Question: Based on the figure, does the quantity rise or fall?
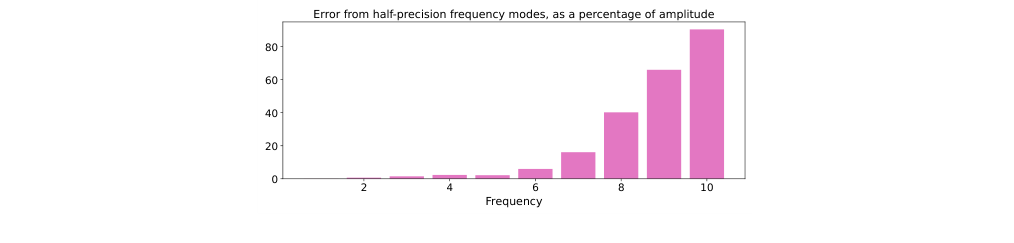
Answer: increasing